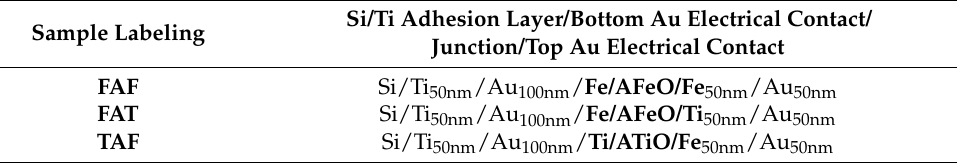
Table 1. List of samples. Sample